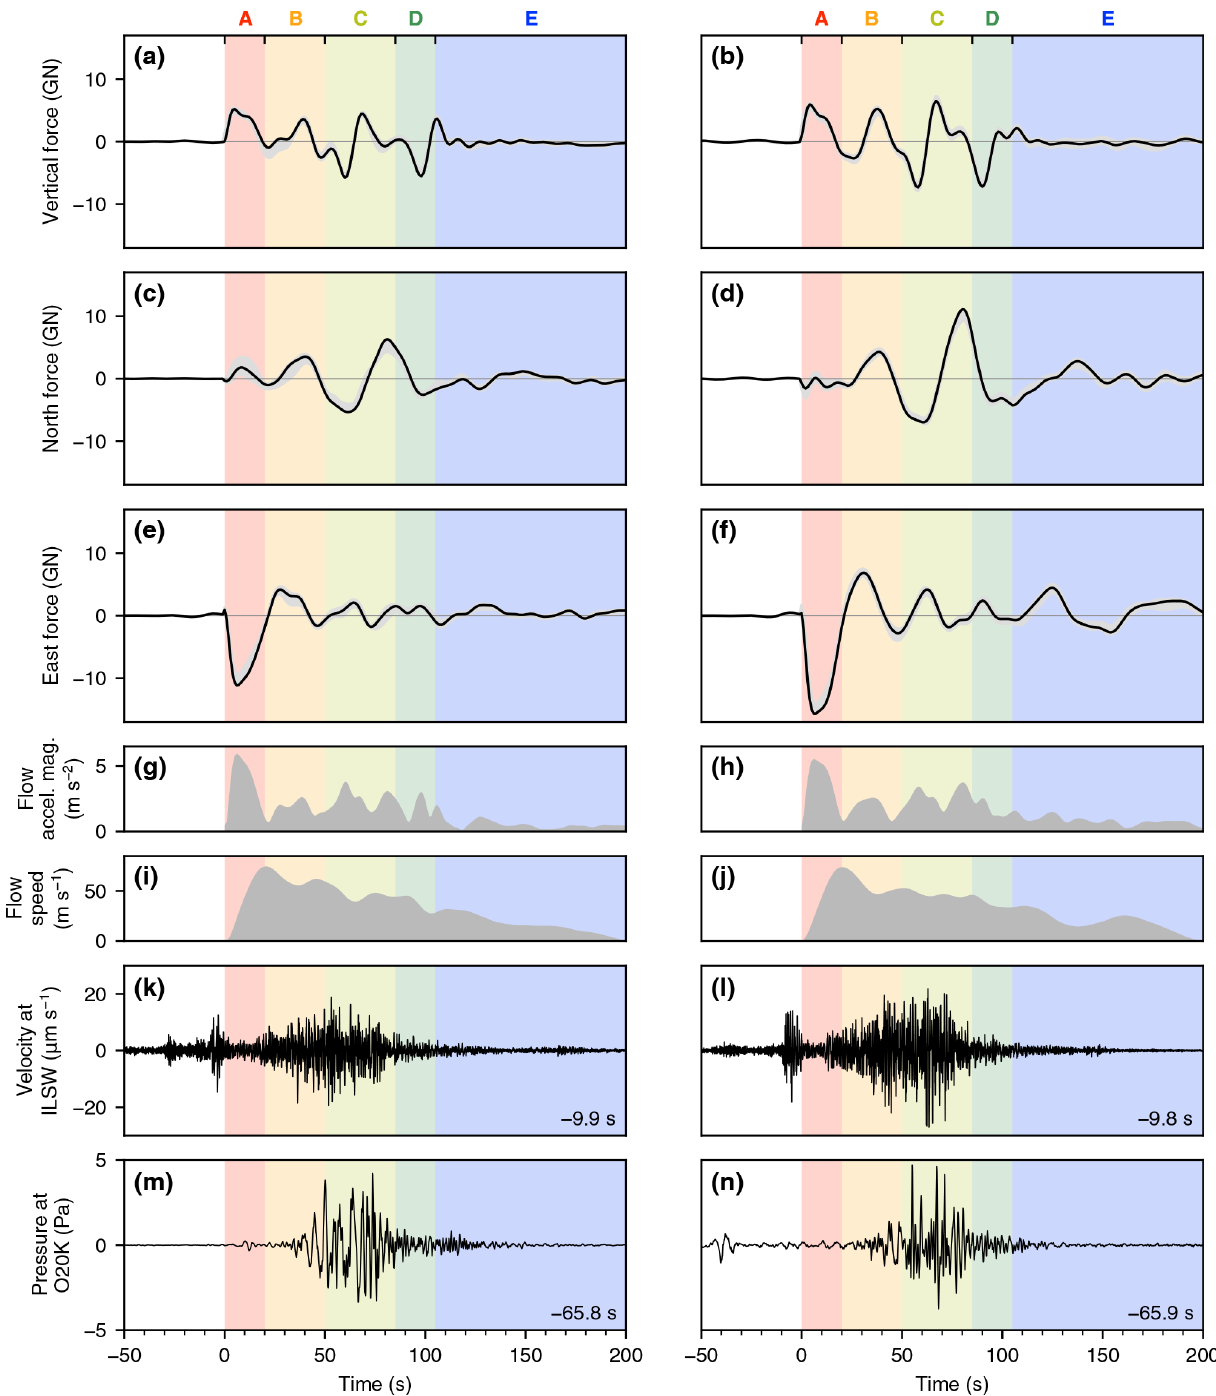
Figure 8. Force inversion results for the 2016 (left column) and 2019 (right column) events with seismoacoustic waveforms for reference. (a–f) Three-component (vertical, north, and east) force-time function f ( t ). Gray patches show the jackknife-derived minimum and maximum forces for f ( t ). (g, h) Force-derived center of mass (COM) acceleration magnitude (cid:107) a ( t ) (cid:107) . (i, j) Force-derived COM speed (cid:107) v ( t ) (cid:107) . (k, l) Vertical-component seismic waveforms from station ILSW shifted for travel time from the avalanche path midpoint using a Rayleigh group wave speed at 1Hz of 900ms − 1 . (m, n) Infrasound waveforms from station O20K shifted for travel time from the avalanche path midpoint using an acoustic wave speed at 10 ◦ C of 337ms − 1 . The time shifts are indicated on the corresponding plots. Seismoacoustic waveforms are high-pass filtered at 0.1Hz. The time axes are relative to the inversion zero time. Vertical axis scales are equal for each row. Colored patches correspond to those in Fig. 10 and the letters A–E in Sect.